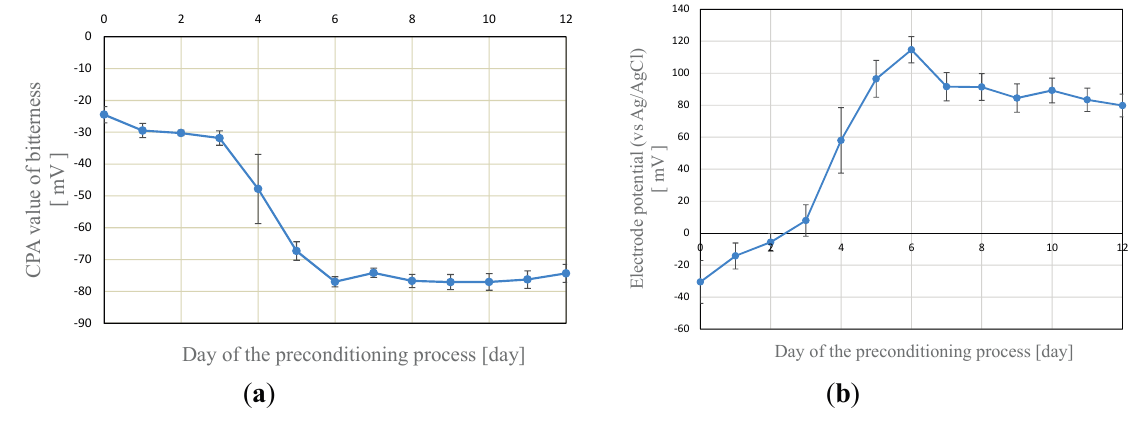
Figure 1. The result of measurements for bitterness sample (0.01 vol% iso- α